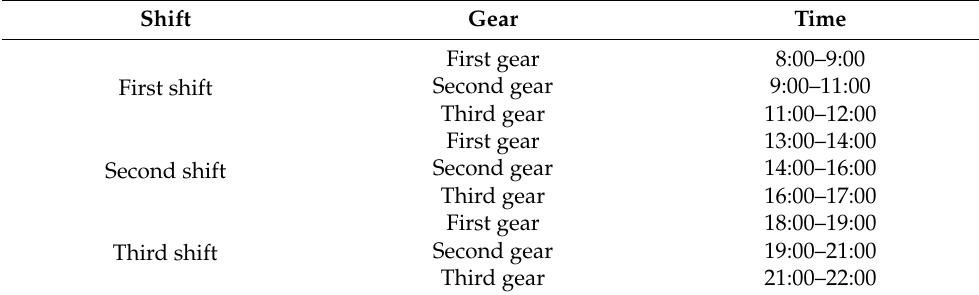
Table 4. Schedule of shifts.